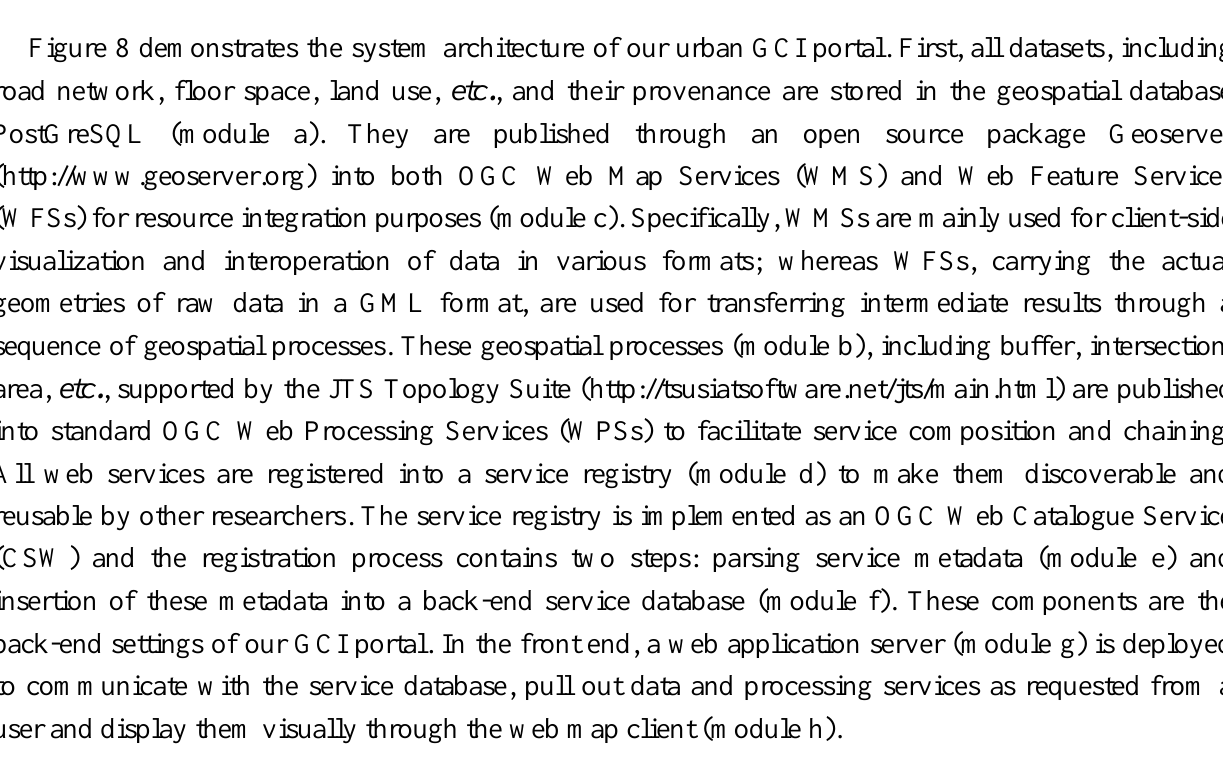
Figure 8. Service-oriented system architecture for the GCI portal. Items in blue show the protocols or standard interfaces for communications between different